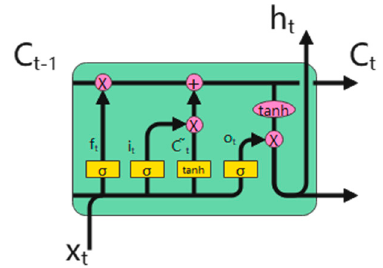
Figure 6. Cell state of LSTM.